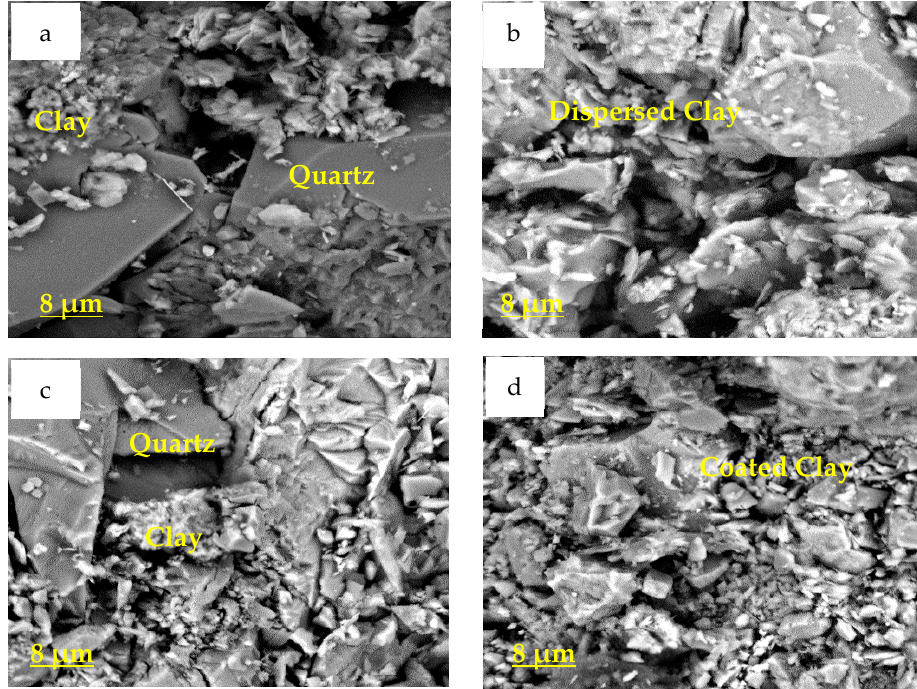
Figure 5. SEM images of ( a ) Berea before flooding, smooth surface ( b ) Clutter Berea after flooding: pore filling dispersed clay ( c ) Bandera Gray before flooding ( d ) Clutter Bandera Gray after flooding, quartz-grain-coated structural clay.